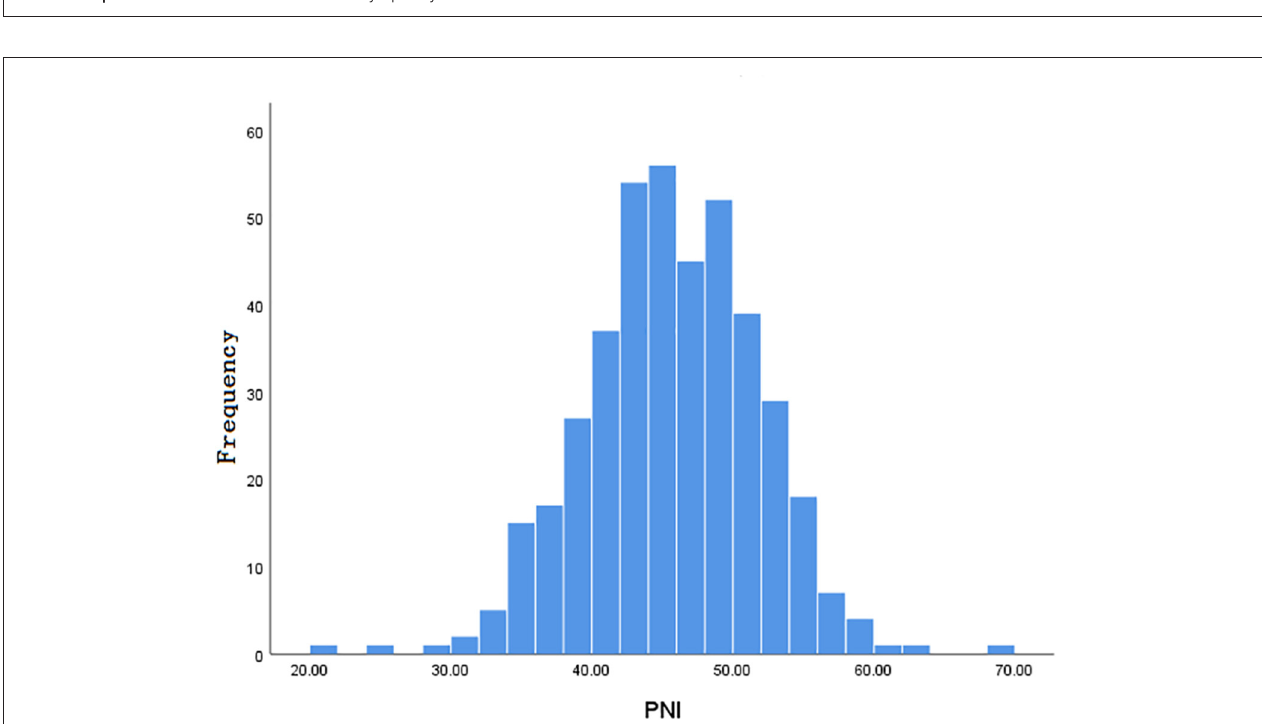
FIGURE 3 | Normal distribution of